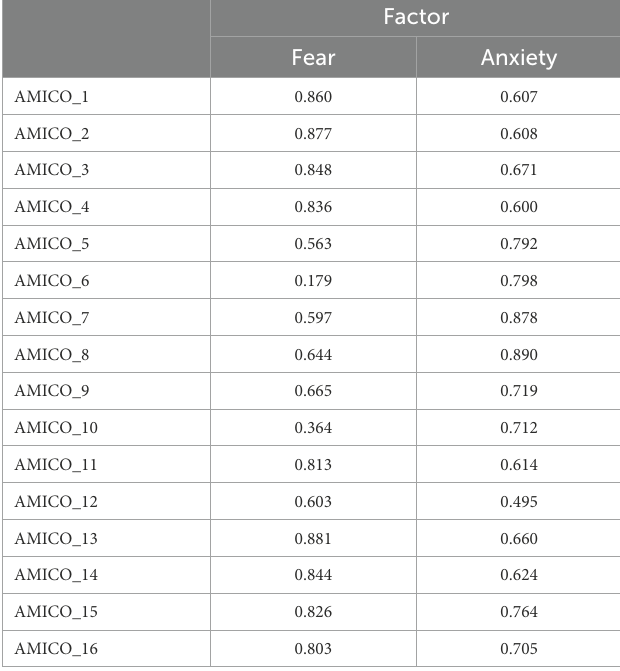
TABLE 3 Rotated component